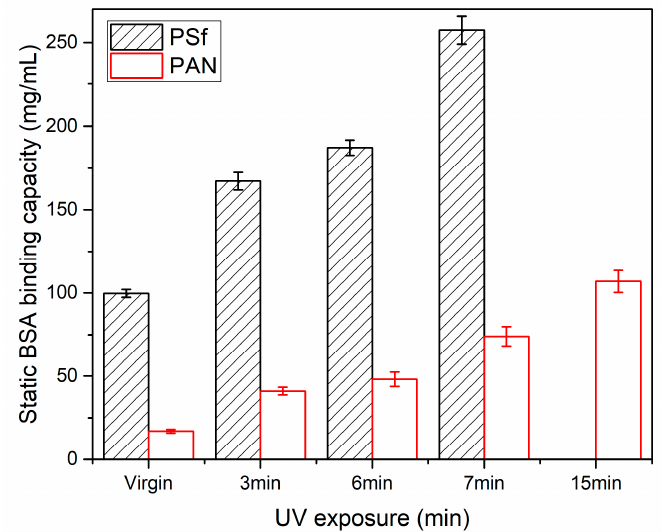
Figure 6. Static binding capacities of unmodified (virgin) and modified PSf and PAN membranes at different UV polymerization times. Error bars represent the standard deviation from 3 measurements. For PAN, the virgin membrane is after NaOH hydrolysis.